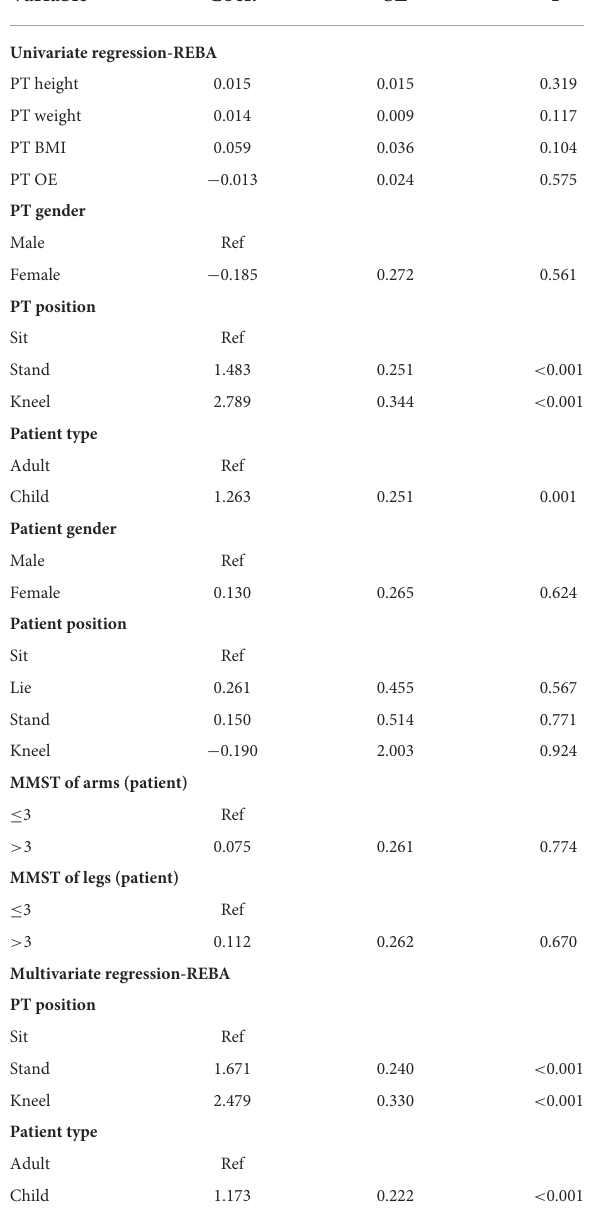
TABLE 3 Coefficient estimates using each physiotherapy variable to predict REBA scores—Univariate. Variable